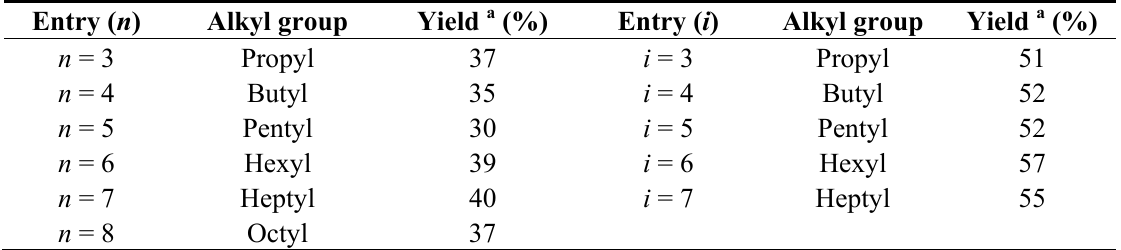
Table 1. Yields of 2-(4'-alkoxybiphen-4-yl)-6-methylquinolines ( n O-PPQMe, n = 3–8)